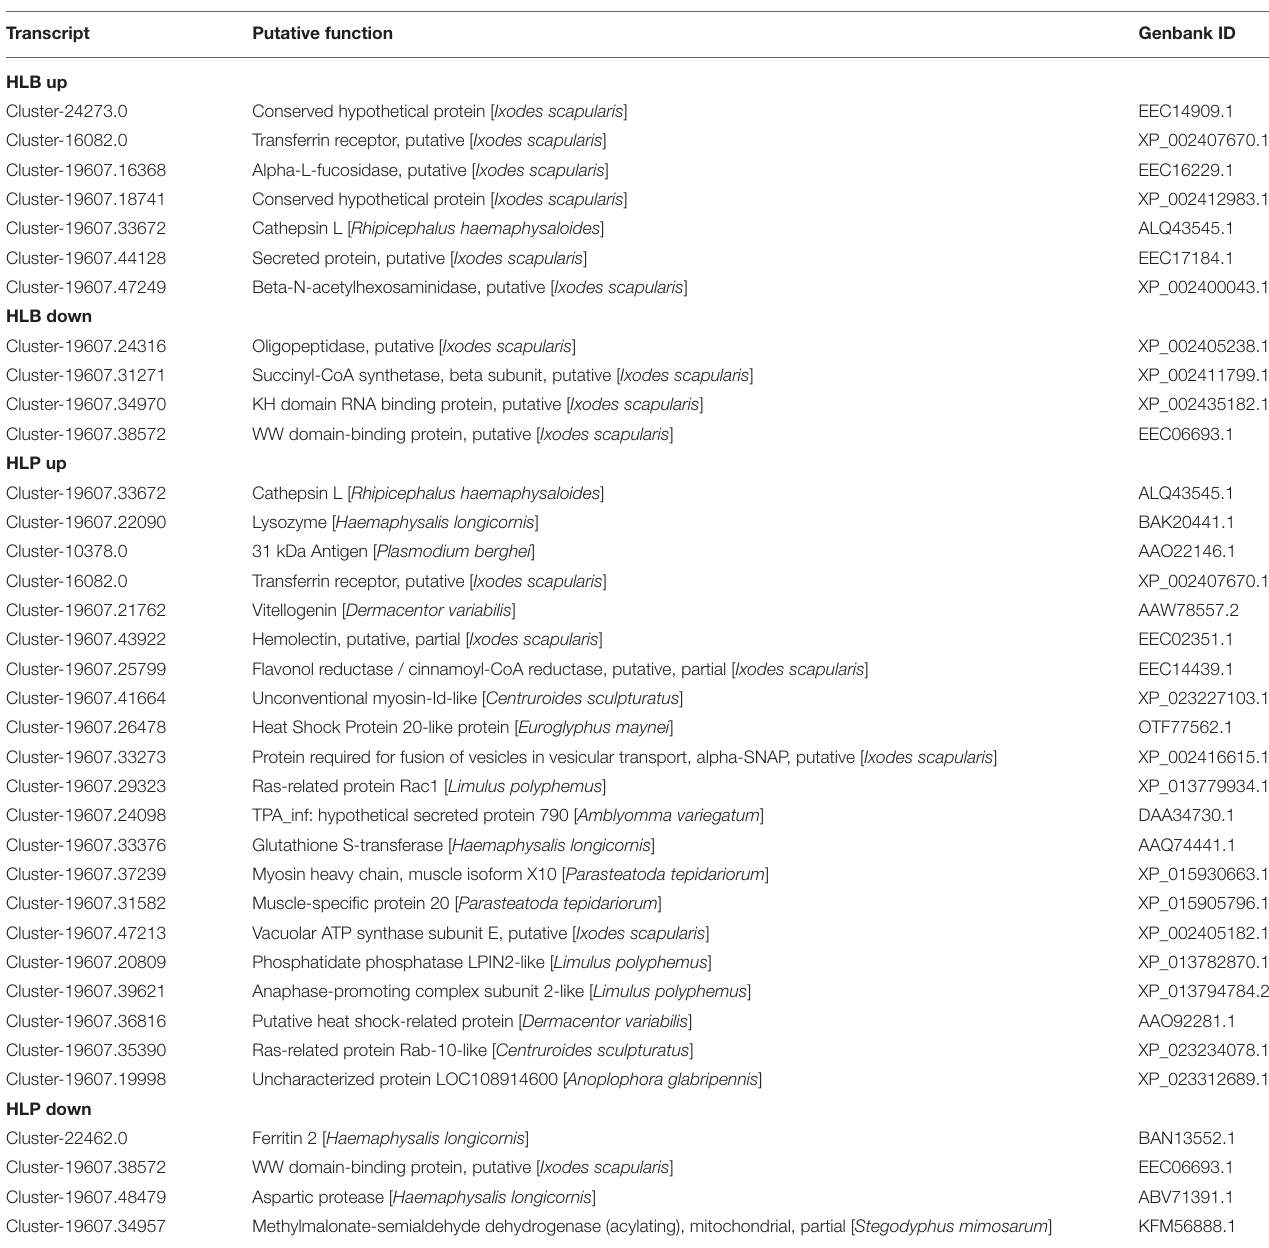
TABLE 1 | Differential expression genes and proteins with the same expression trends in the ovary of the HLBP and HLPP.